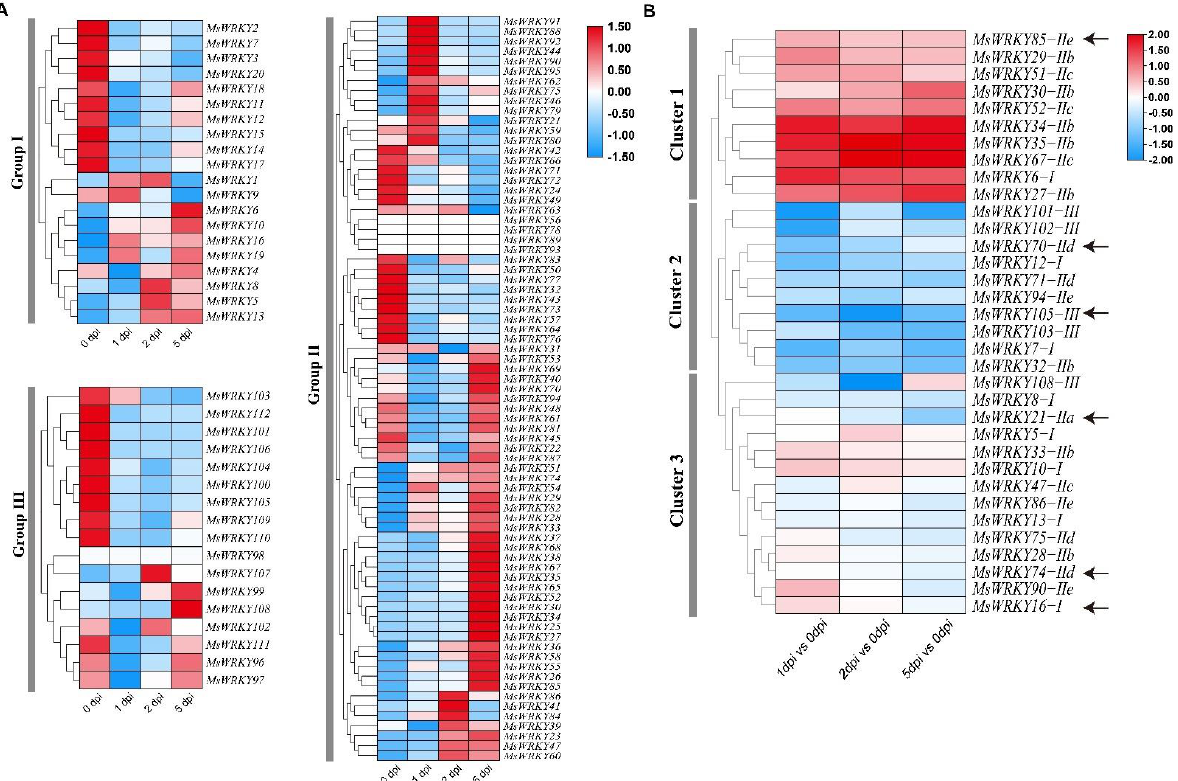
Figure 4. Expression profiles of the 112 MsWRKY transcripts during the response to the infection of V. mali . ( A ) Heatmaps with clustering separately represent the expression profiles of the three groups of MsWRKY transcripts at 0, 1, 2, 5 dpi. Color scale represented with the normalized FPKM values. Red, blue and white indicated high expression, low expression and no expression, respectively. ( B ) The expression profiles of the differential expression 34 MsWRKY transcripts at 0, 1, 2, 5 dpi. The cut-off of the differentially expressed transcripts was |log 2 (Fold change)| > 1, Q < 0.05. Color scale represented the fold change of V. mali infection vs. 0 dpi control with normalized log 2 (Fold change) values. Red, blue and white indicated high expression, low expression and no expression, respectively. The cut-off of the differentially expressed MsWRKY transcripts was |log2 (fold change)| ≥ 1, the Q -value was <0.05.